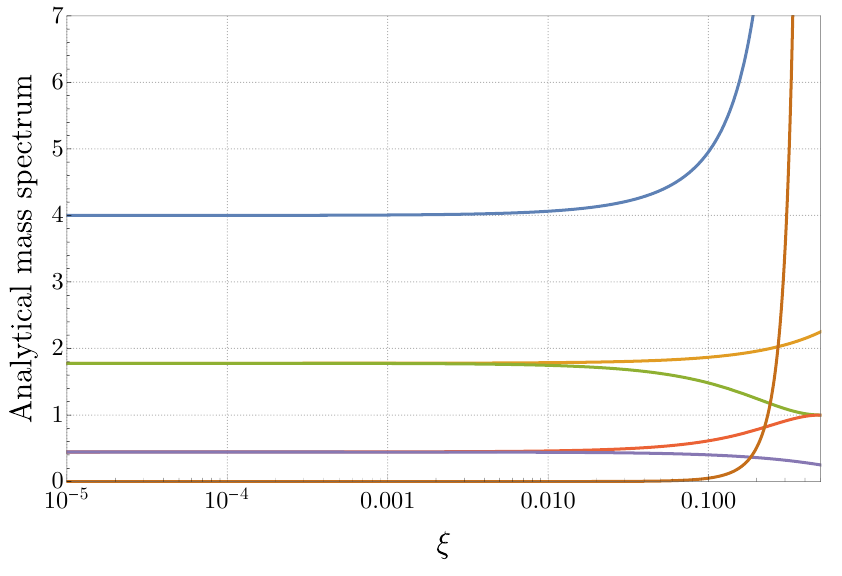
Figure 2 . Evolution of the scalar mass spectrum (4.54) with respect to the LCS parameter ξ . The correspondence between the curves and the labels ± λ of the different modes is as follows: blue curve is +1 ; orange curve is + λ , λ = 2 , . . . , h 2 , 1 ; green curve is +0 ; red curve is − 0 ; purple curve is − λ , λ = 2 , . . . , h 2 , 1 and Brown curve is − 1